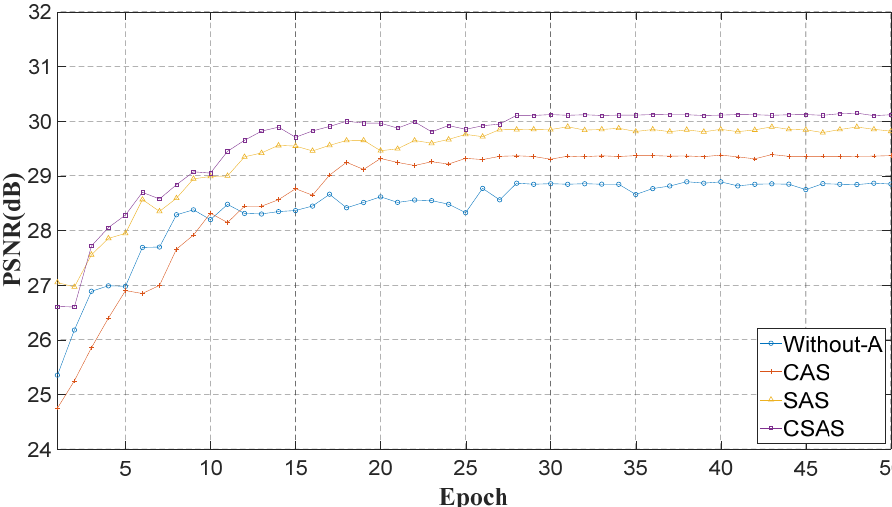
Figure 6. PSNR curves of various attention mechanisms.